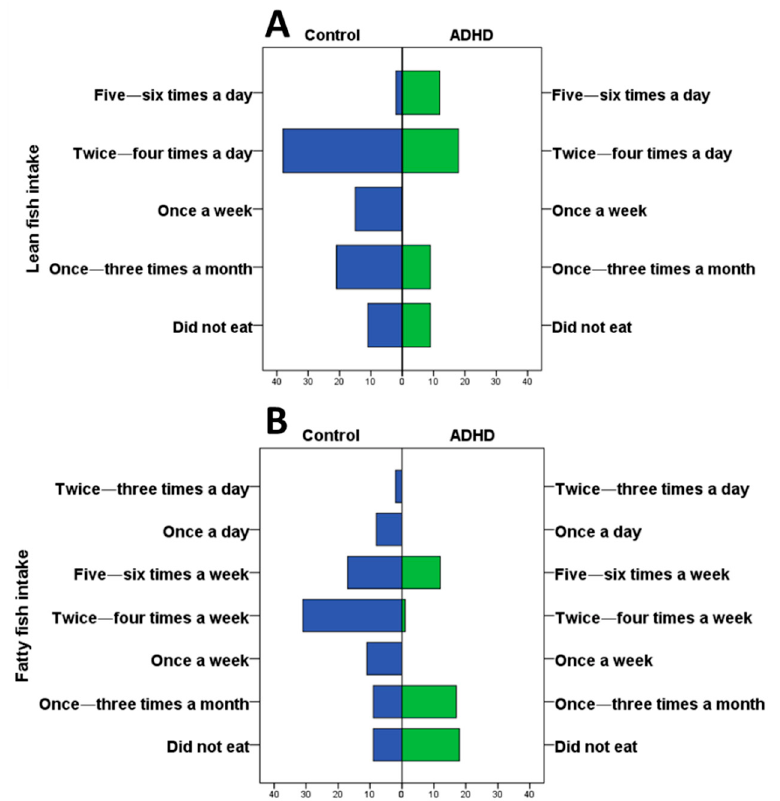
Figure 1. Frequency of intake of lean and fatty fish (Supplementary Table S1 and Table S2 for raw).